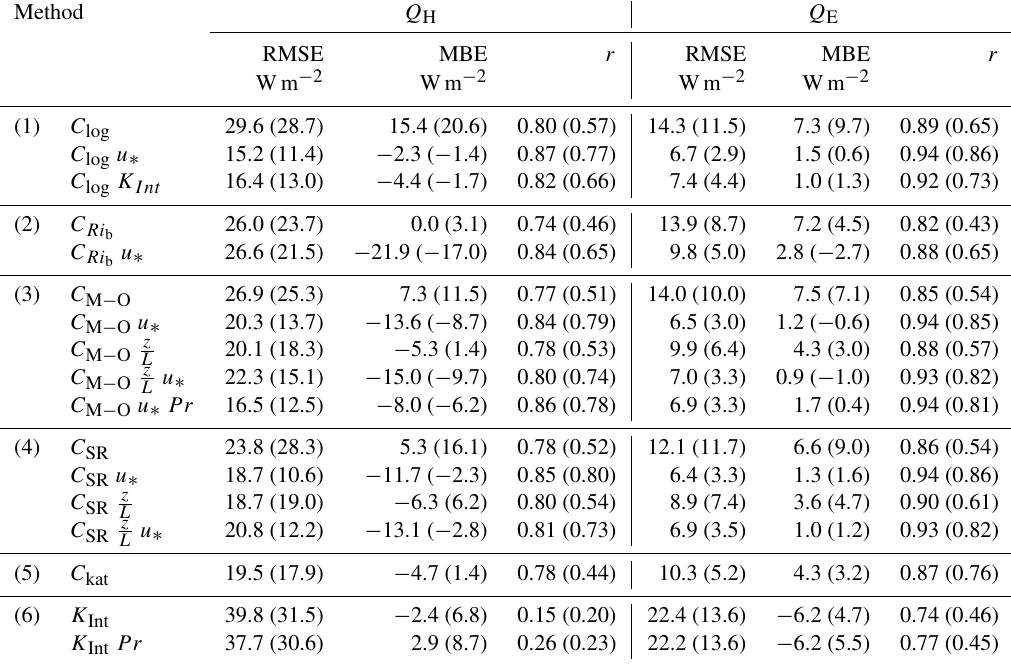
Table 2. Comparison between modeled and OPEC-derived sensible ( Q H ) and latent ( Q E ) heat fluxes, expressed as root mean square error (RMSE), mean bias error (modeled minus observed; MBE), and Pearson correlation coefficient ( r ) for 2012 and 2010 (values in parentheses) observational periods, given for a set of six bulk methods and their variants (see text).